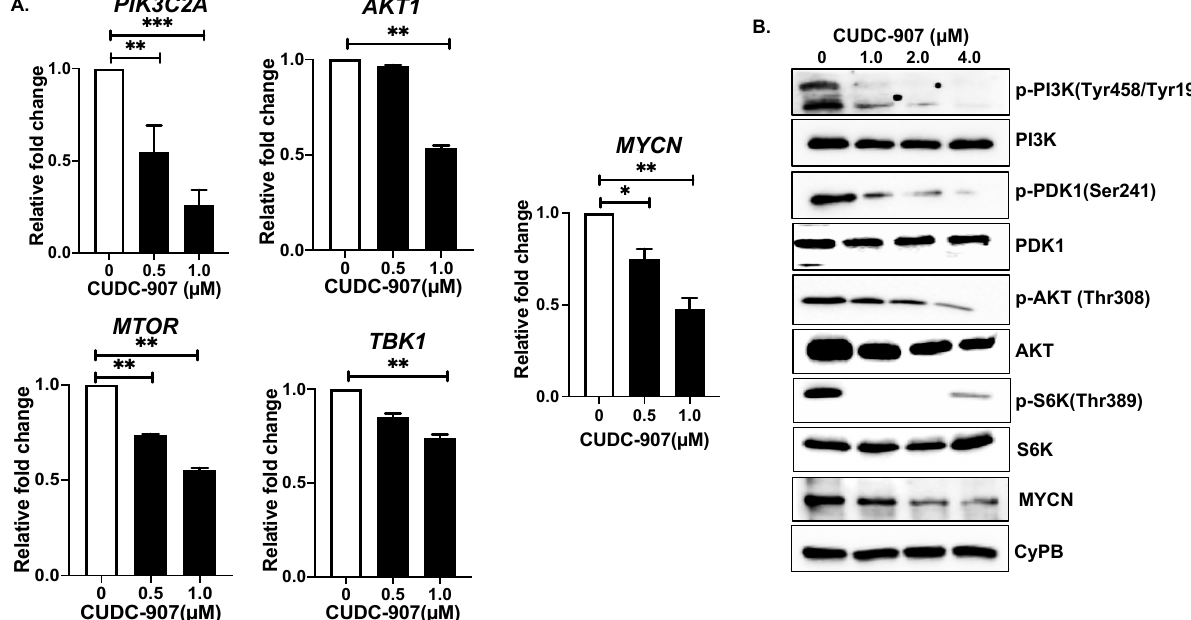
Figure 6. CUDC-907 inhibits PI3K/AKT pathway: ( A ) Gene expression analysis of PIK3C2A , AKT1 , MTOR , TBK1 , and MYCN in response to CUDC-907 treatments in SH-SY5Y cells. * p < 0.05, ** p < 0.01, and *** p < 0.001. ( B ) Western blot analysis of different PI3K pathway proteins in response to increasing concentrations of CUDC-907 treatments. CyPB was used as a loading control. Full blots and densitometric data are available in Supplementary Figure S2.